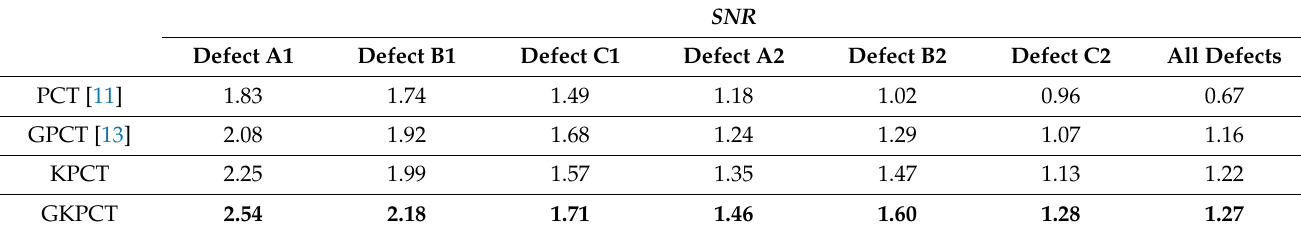
The value in bold indicates the maximum SNR value corresponding to the Figure 15. Schematic diagram of image segmentation with the improved SNR calculation.